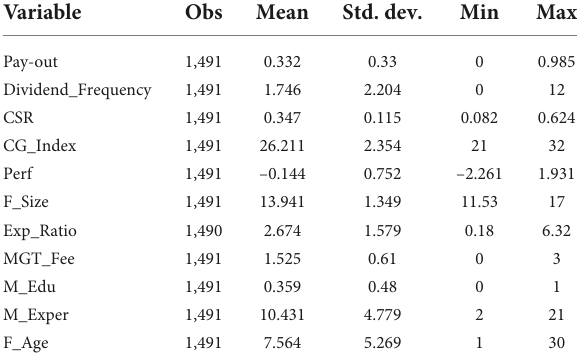
TABLE 2 Descriptive statistics of the